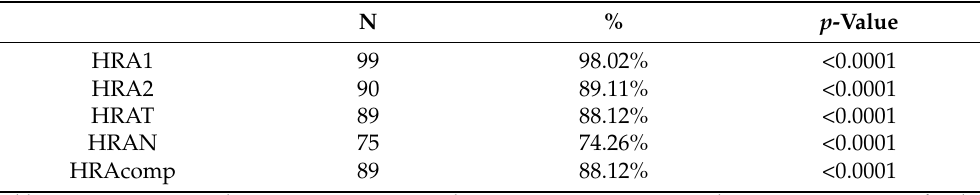
Table 2. The prevalence of short-term, long-term, total HRA, and HRA compensation in the study group (n = 101) of carefully selected healthy individuals during 48-h ECG recordings.